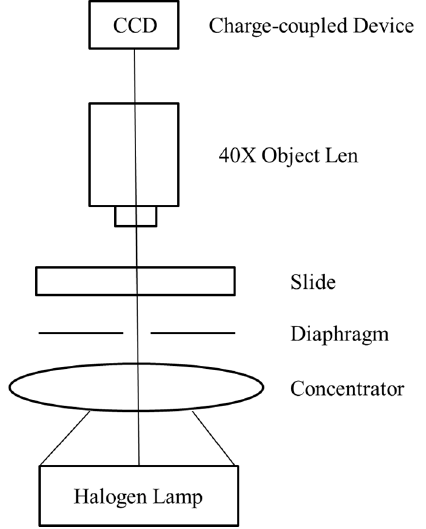
Figure 6. The optical system for capturing TV videos.